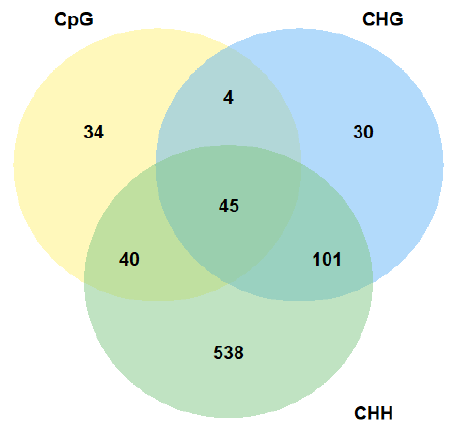
Figure 3. Number of differentially methylated Arabidopsis thaliana genes in different sequence